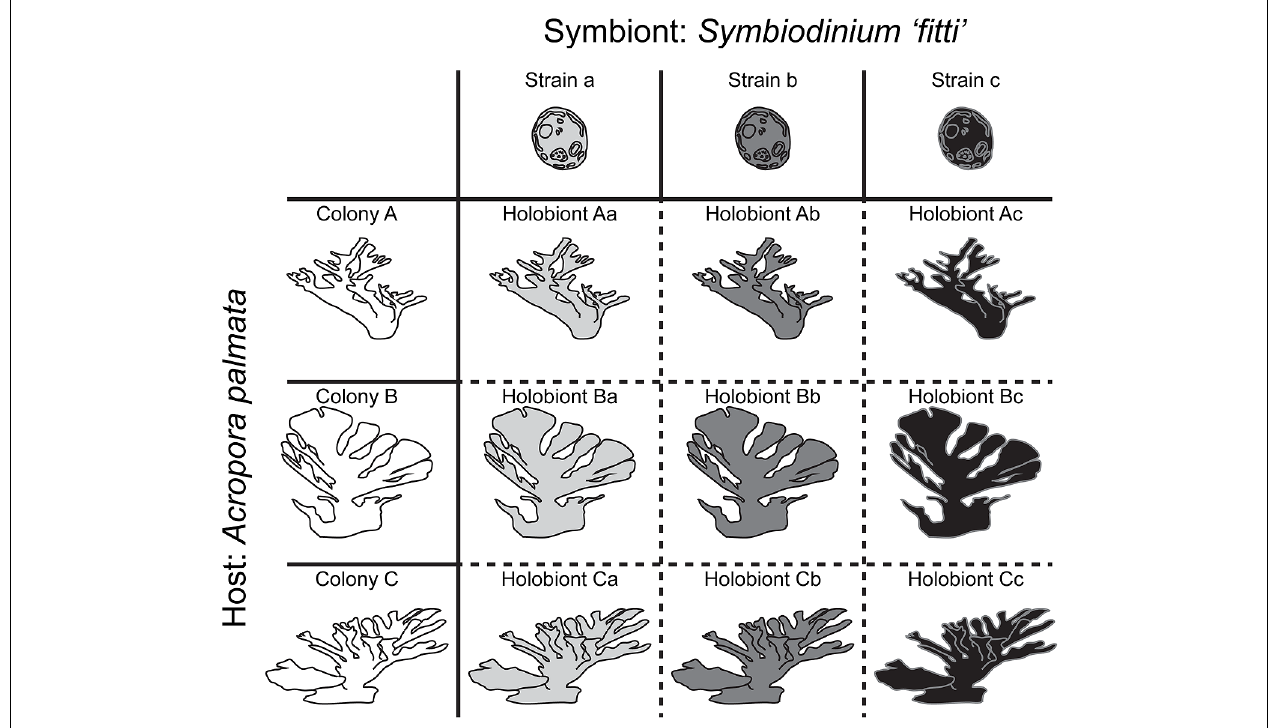
FIGURE 1 | Diagram showing how coral–algal holobionts represent unique pairings of partner genotypes in the Acropora palmata– Symbiodinium “fitti” association. Host genotype (colony) is indicated by shape; symbiont genotype (strain) is indicated by color. In this